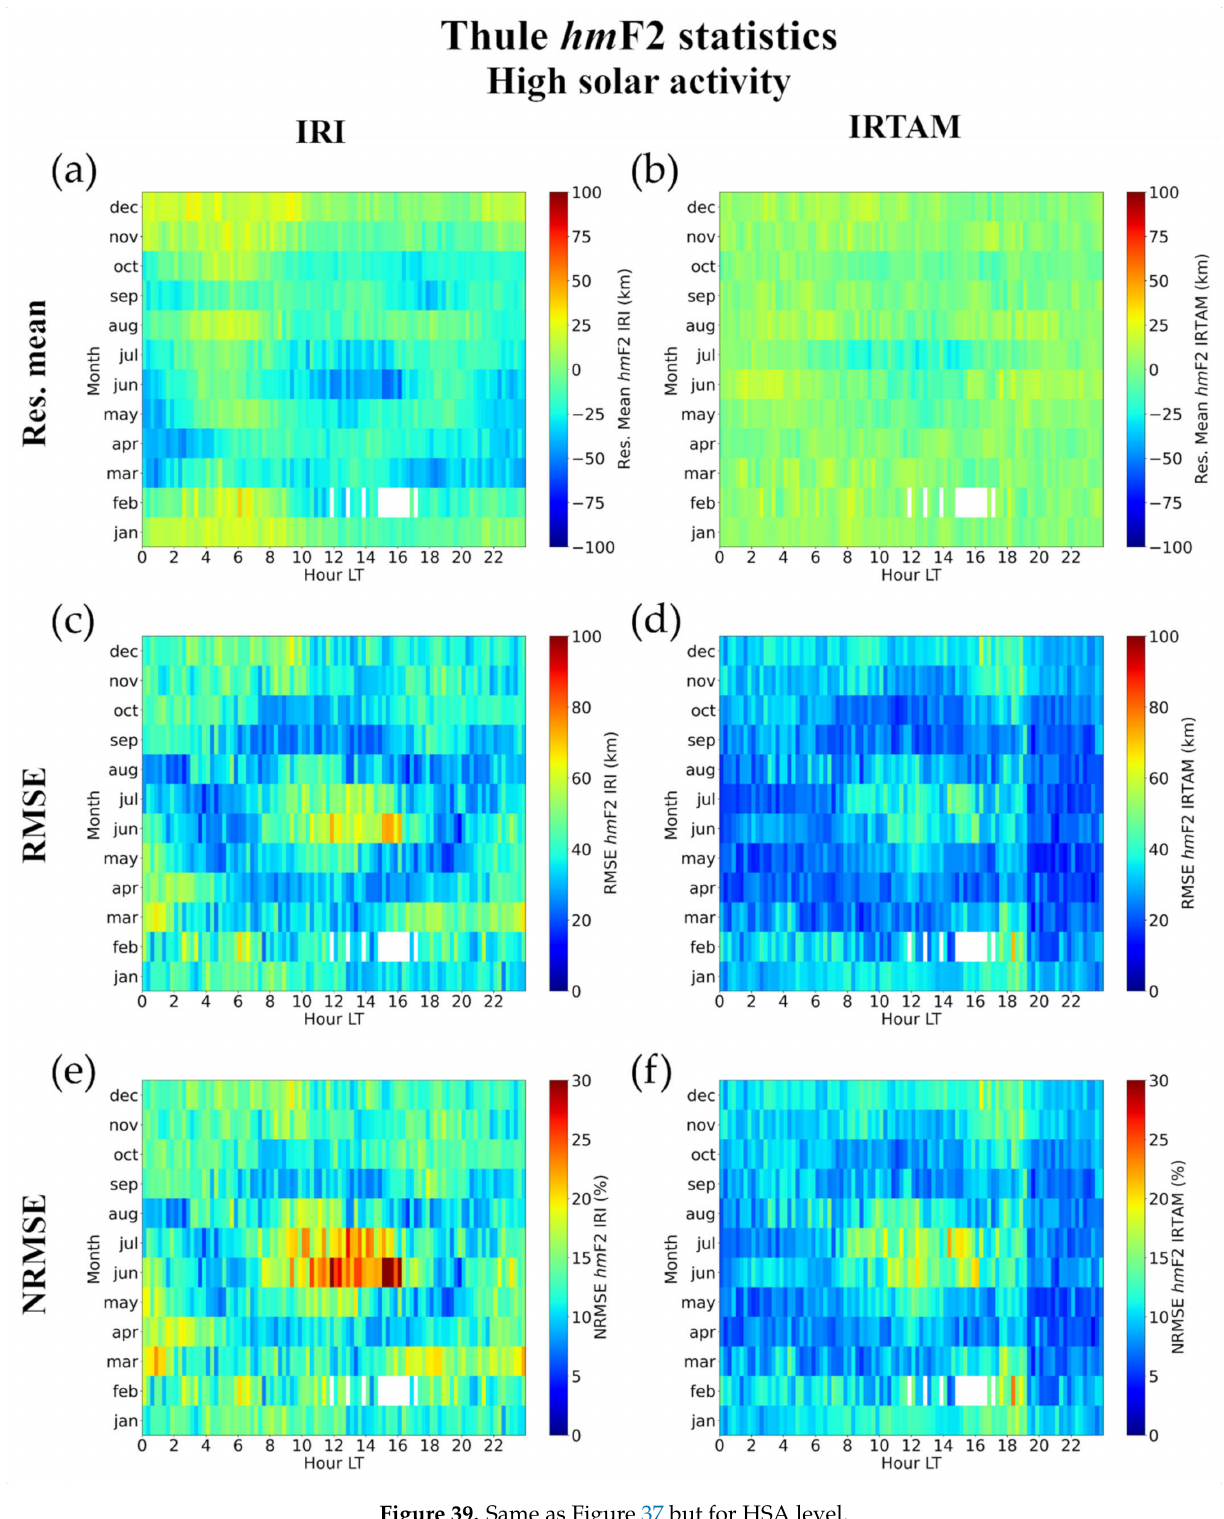
Figure 39. Same as Figure 37 but for HSA